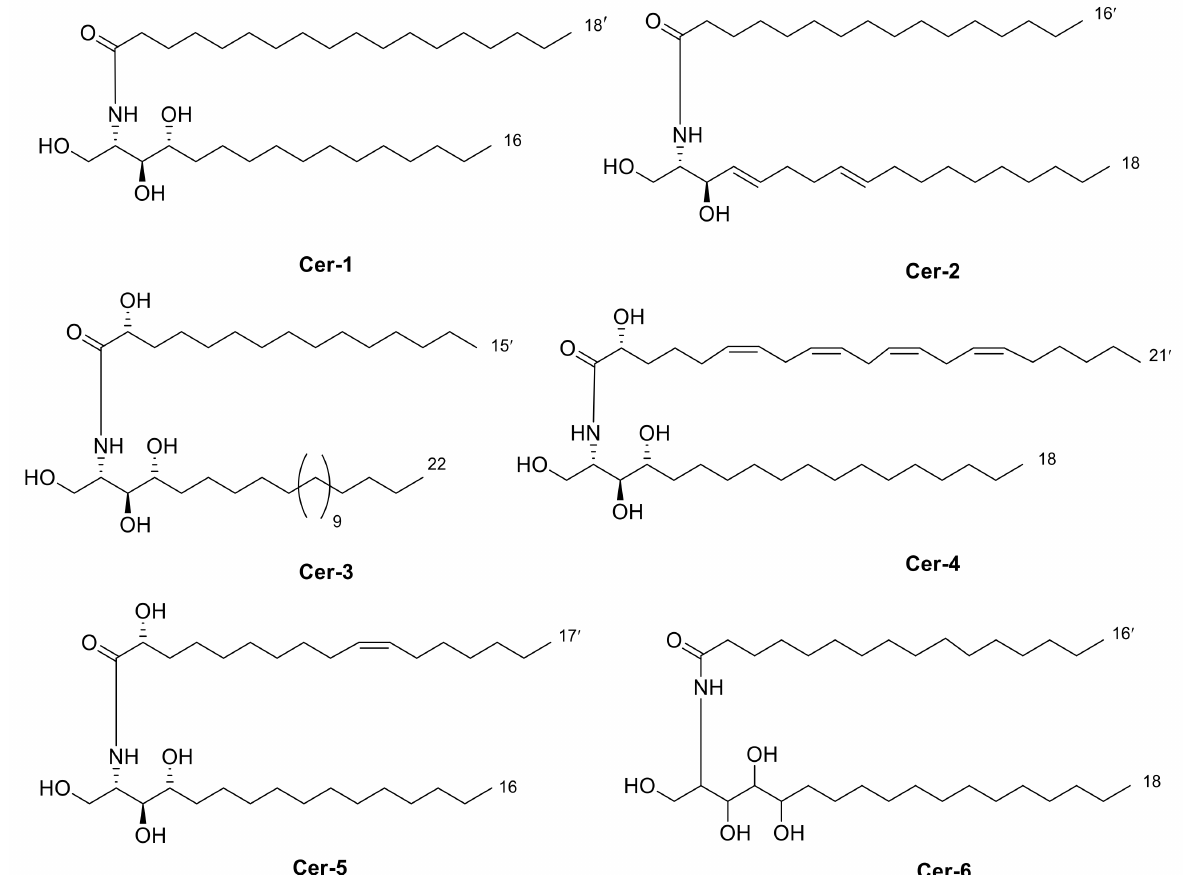
Figure 1. Chemical structures of isolated compounds 1–6